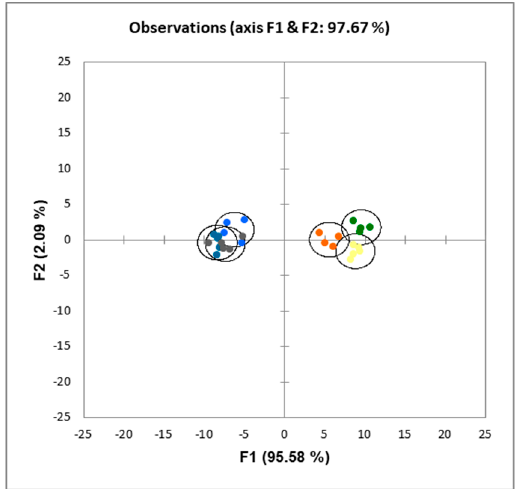
Figure 4. Discriminant analysis of visceral fat fatty acid composition of rats fed CAS (yellow); CAS-OB (grey); KEM (orange); KEM-OB (dark blue); PEM (green); PEM-OB (light blue). For details on the were different ( p < 0.01) from CAS, PEM, and KEM, but not different to each other.